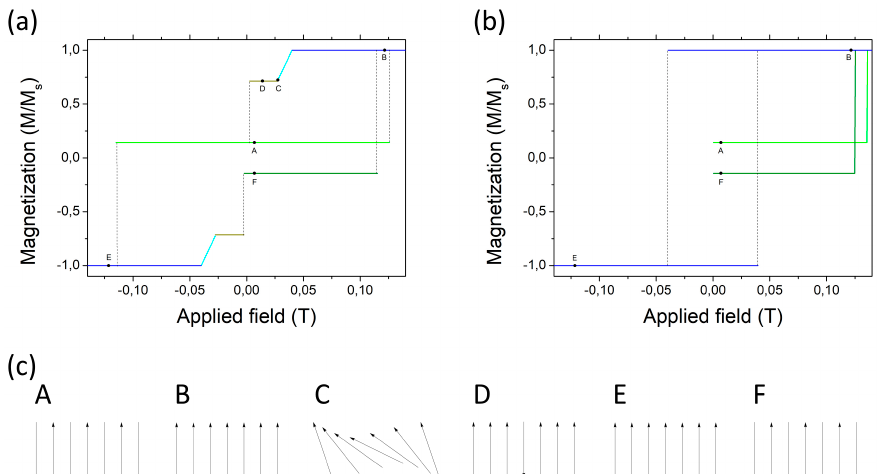
Figure 5. Magnetization sequence under the applied magnetic field in a S-W model of ( a ) 7 stripes, ( b ) 7 ellipsoids. The starting configuration for H = 0 is antiferromagnetic. Panel ( c ) represents the stages of magnetization switching in the case of the stripes marked with the letters A, B, C, D, E and F. Mind that configurations A and F are two variants of AF configuration with the net magnetization upwards (AF-u) and downwards (AF-d), respectively.